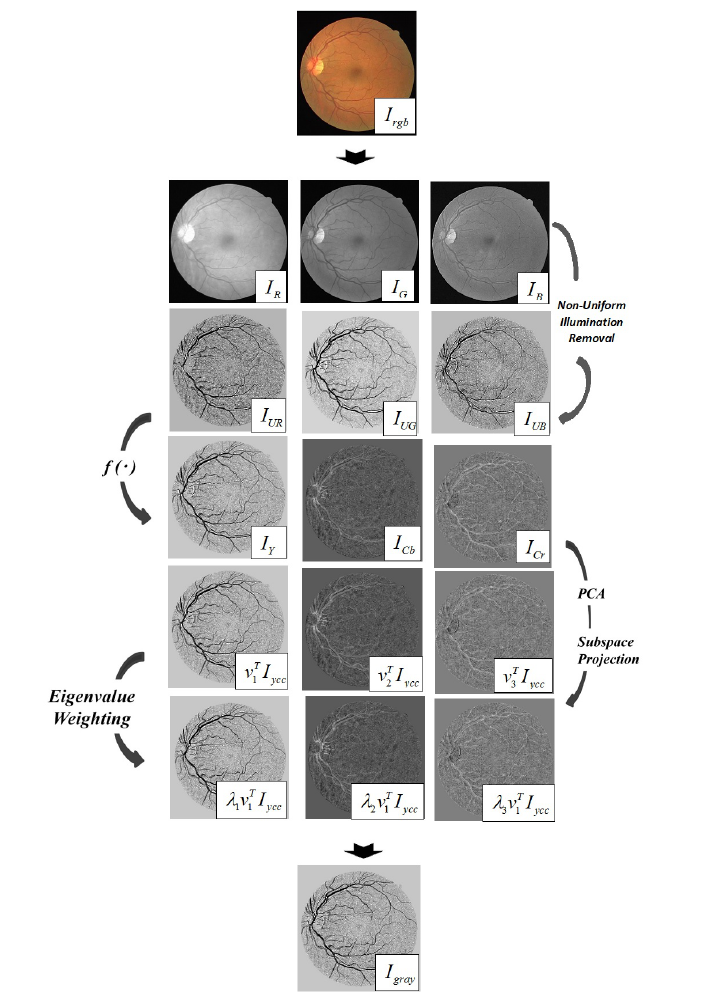
Figure 5. PCA Conversion